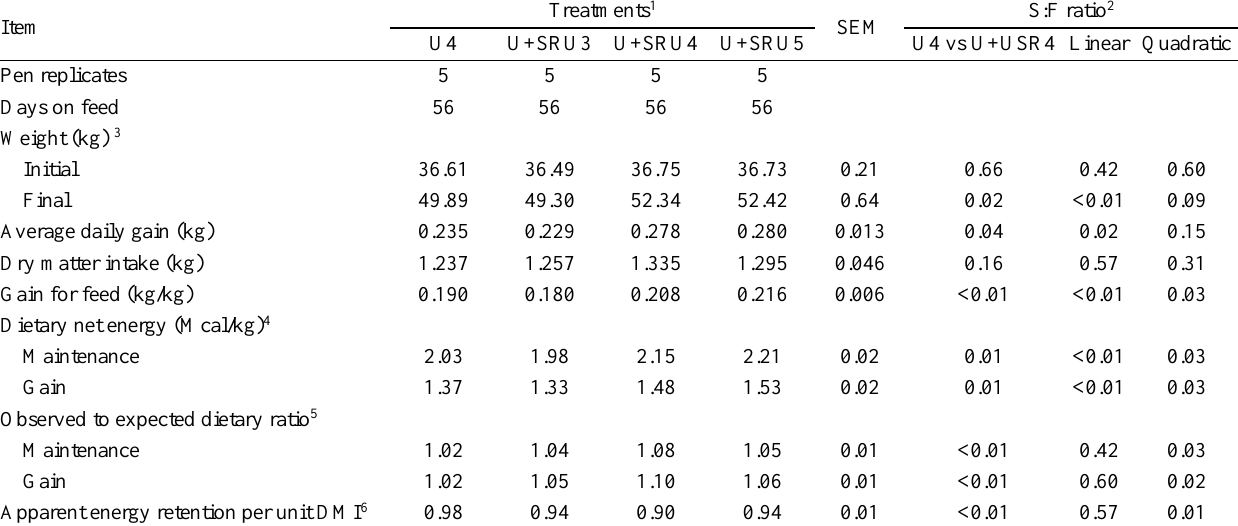
Table 2 . Influence of treatments on growth performance and dietary energy of